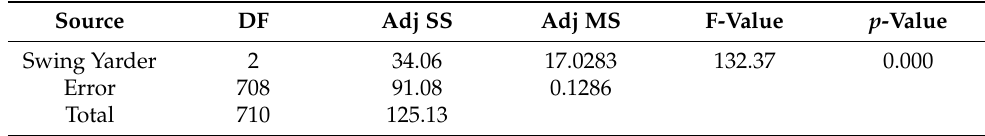
Table 2. ANOVA of unhooking time of swing yarders.